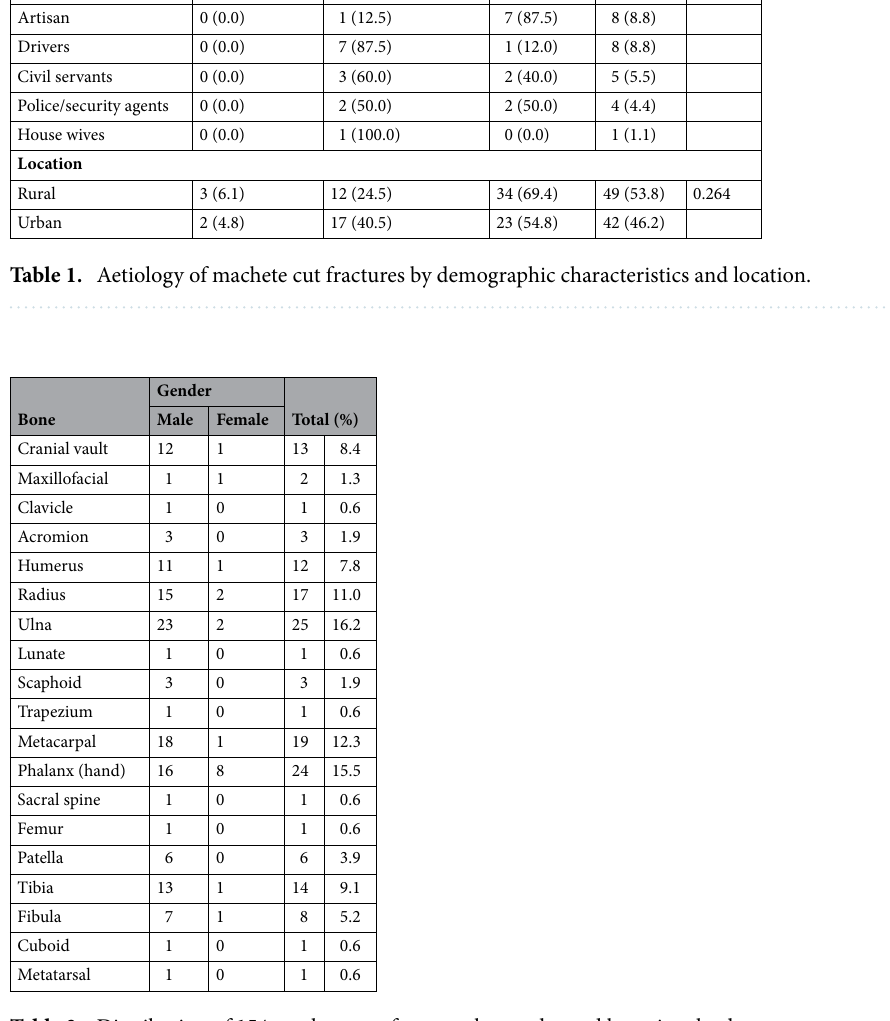
Table 2. Distribution of 154 machete-cut fractures by gender and bone